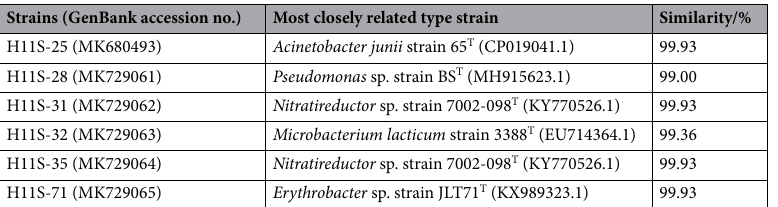
Table 1. The oil-degrading bacteria isolated from the enrichment consortium H11S and the corresponding type strains.